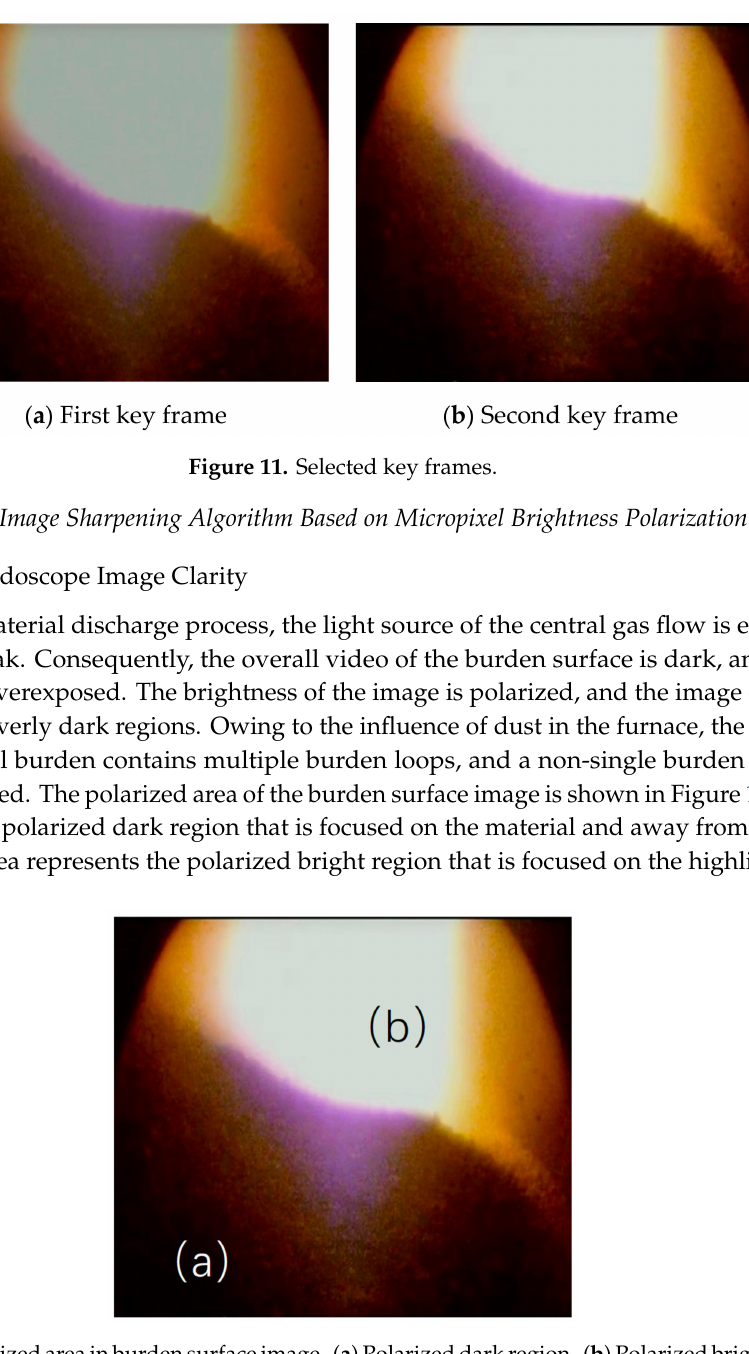
Figure 12. Polarized area in burden surface image. ( a ) Polarized dark region. ( b ) Polarized bright